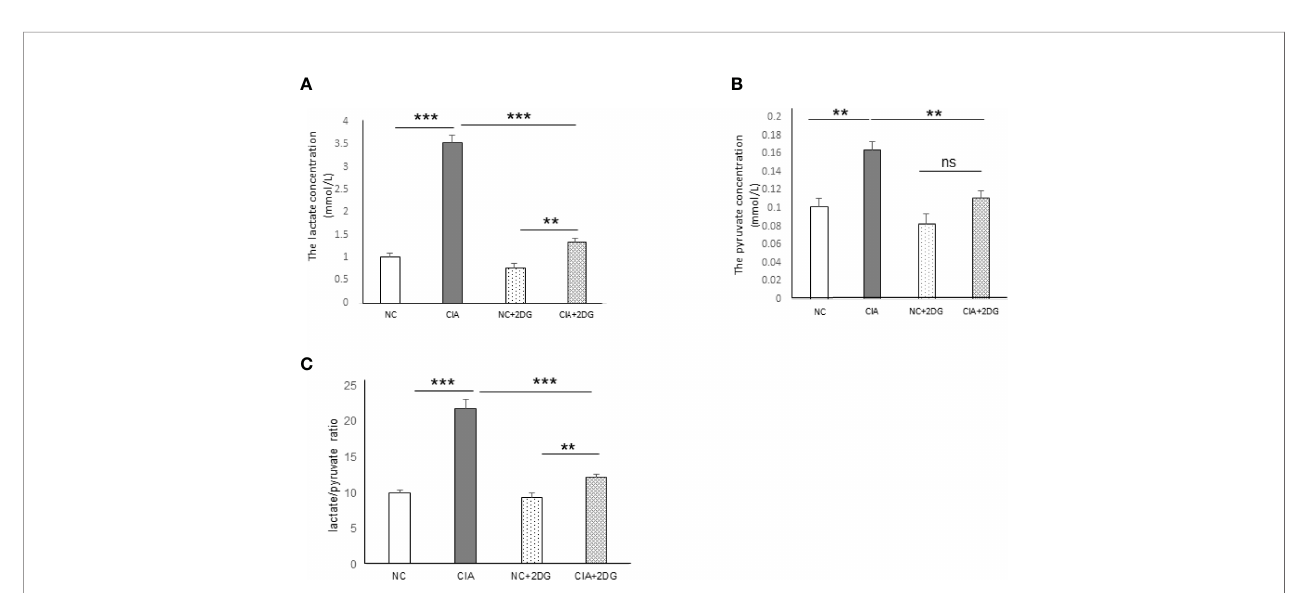
FIGURE 3 | The effect of 2-DG treatment on lactate and pyruvate production in CIA rats. The concentrations of lactate (A) and pyruvate (B), as well as the lactate/ pyruvate ratio (LPR) (C), were measured in the peripheral blood of the rats that were treated with PBS (n=6) or 2-DG (n=6). The healthy rats (NC) treated with PBS (n=6) or 2-DG (n=6) were used as controls. **p < 0.01, ***p < 0.001 and ns, not signi fi cant